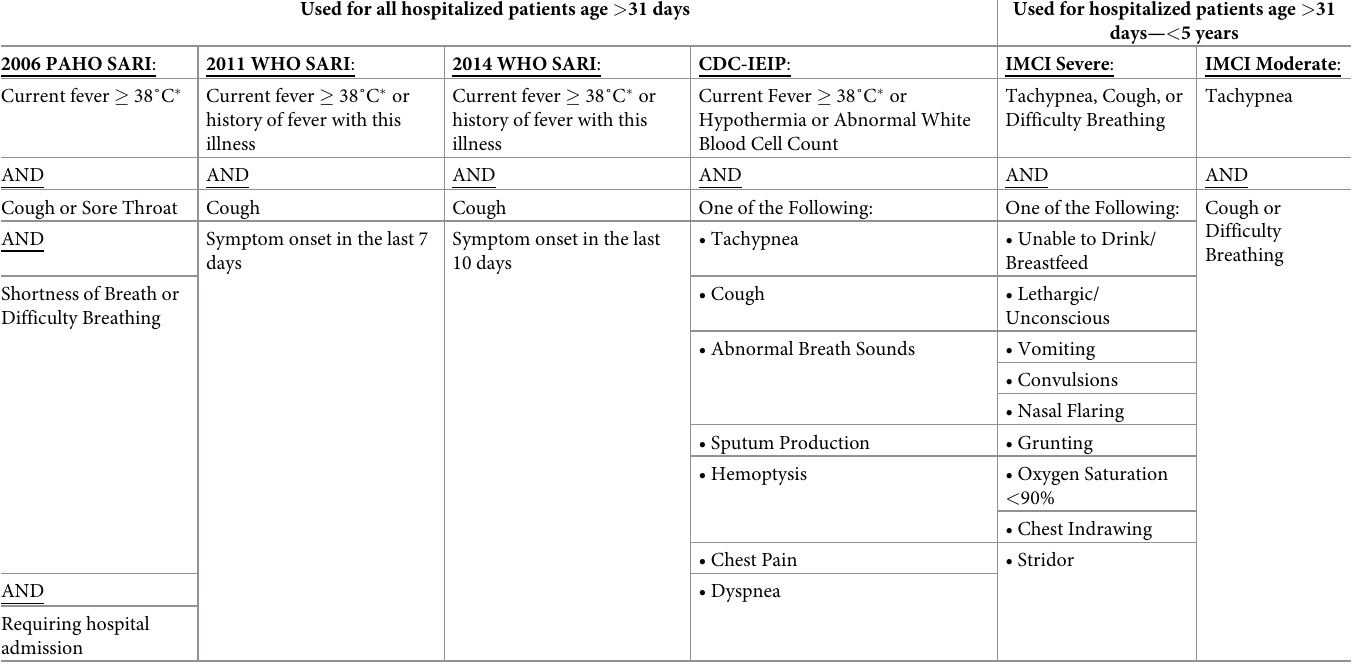
Table 1. Case definitions used for